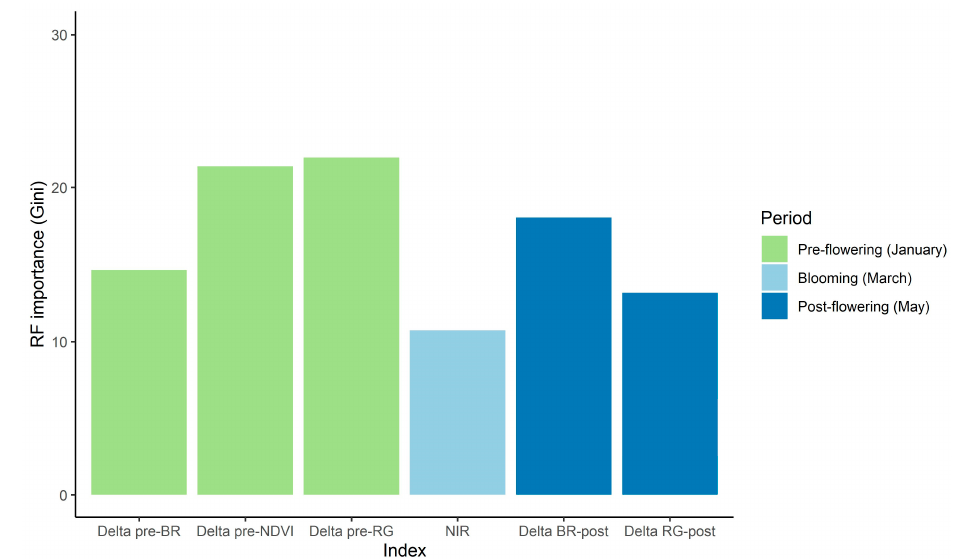
Figure 4. Metric importance from the best random forest model that includes six Sentinel-2